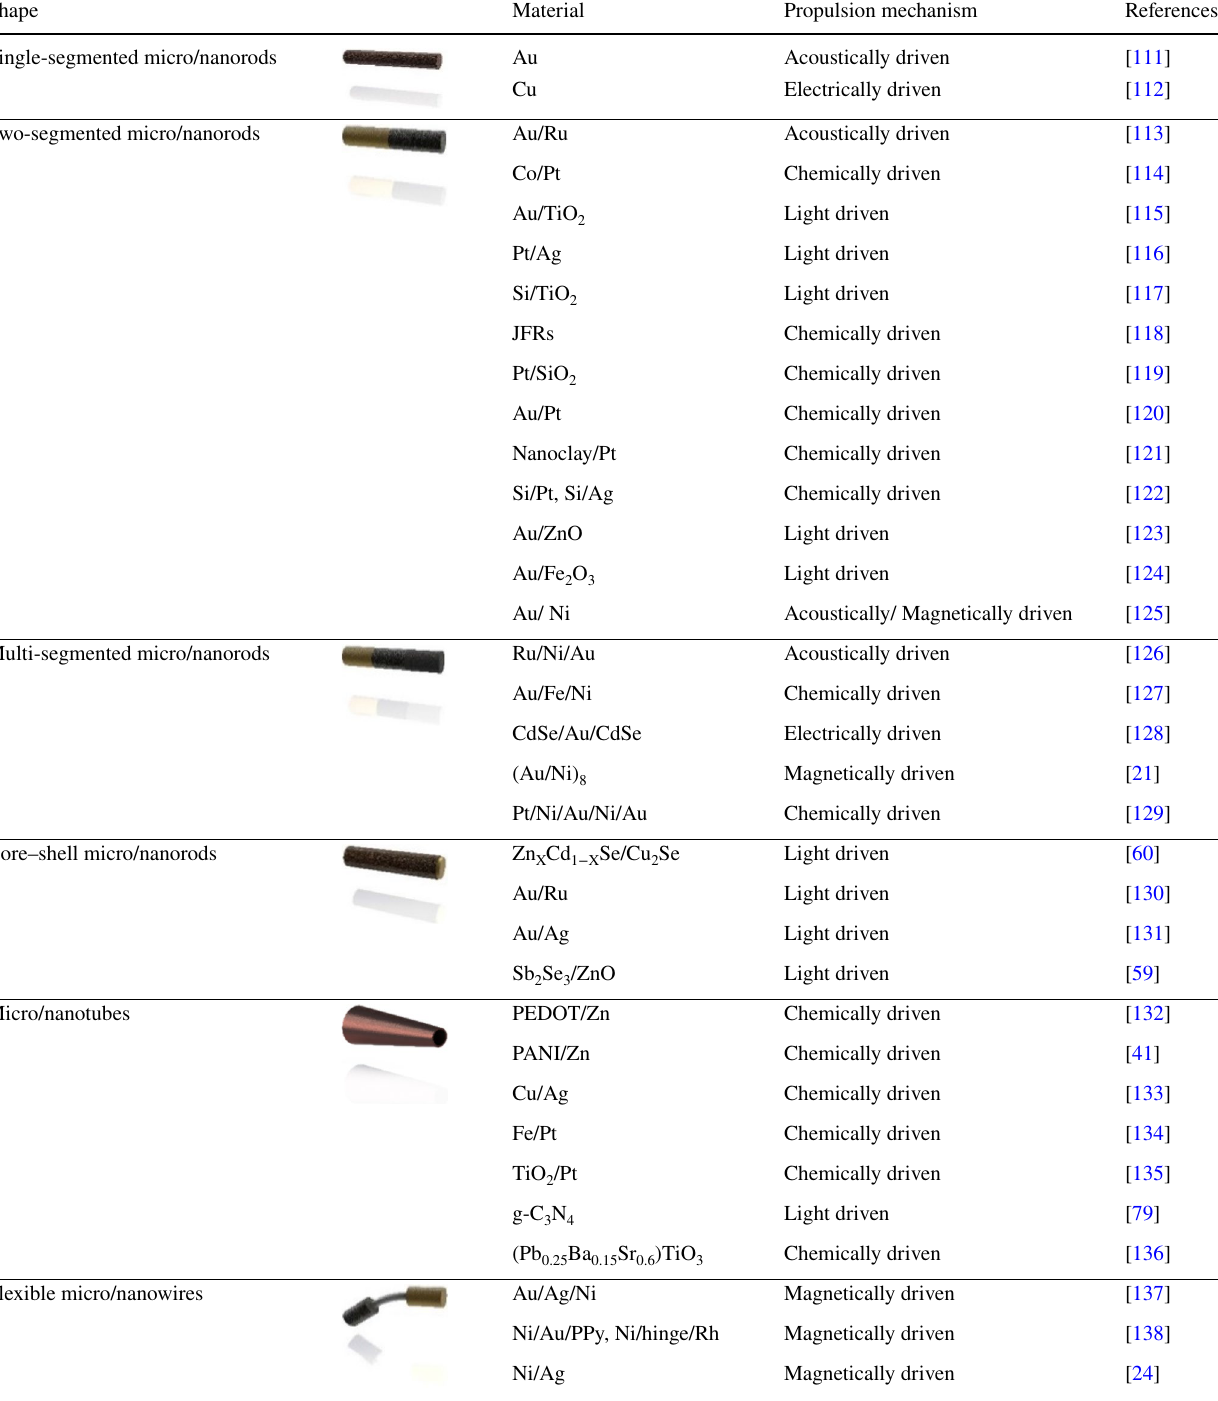
Table 1 1D micro/nanomotors with different shapes and materials